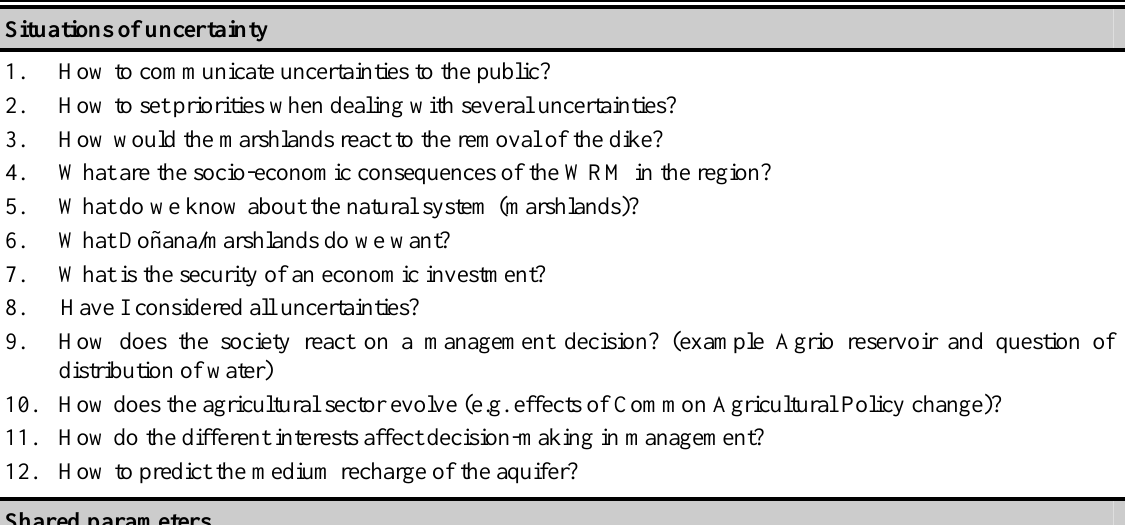
Table A2.3. Uncertainty workshop. Upper panel: situations of uncertainty relevant to the professional work of the participants. Lower panel: shared